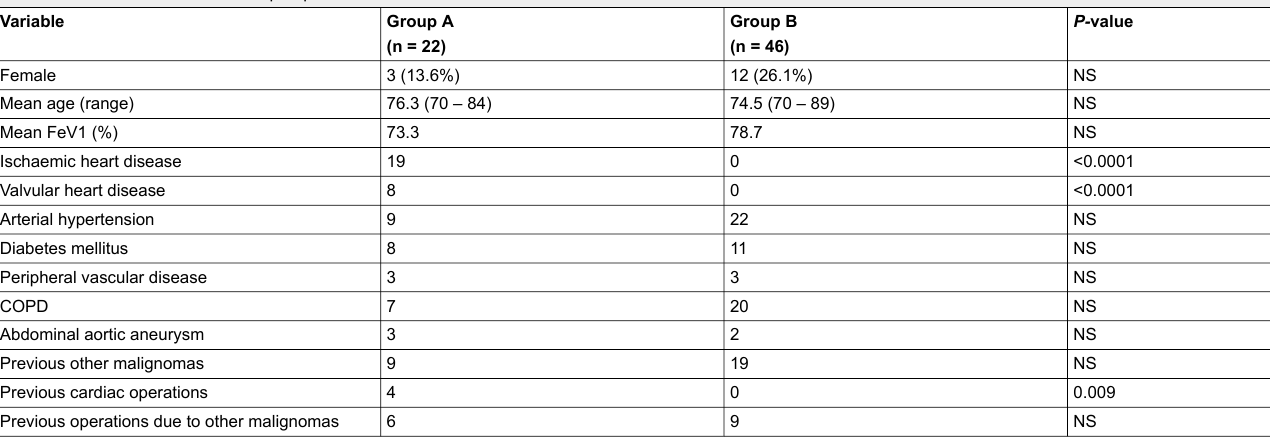
Table 1: Patient characteristics and preoperative comorbidities. Variable